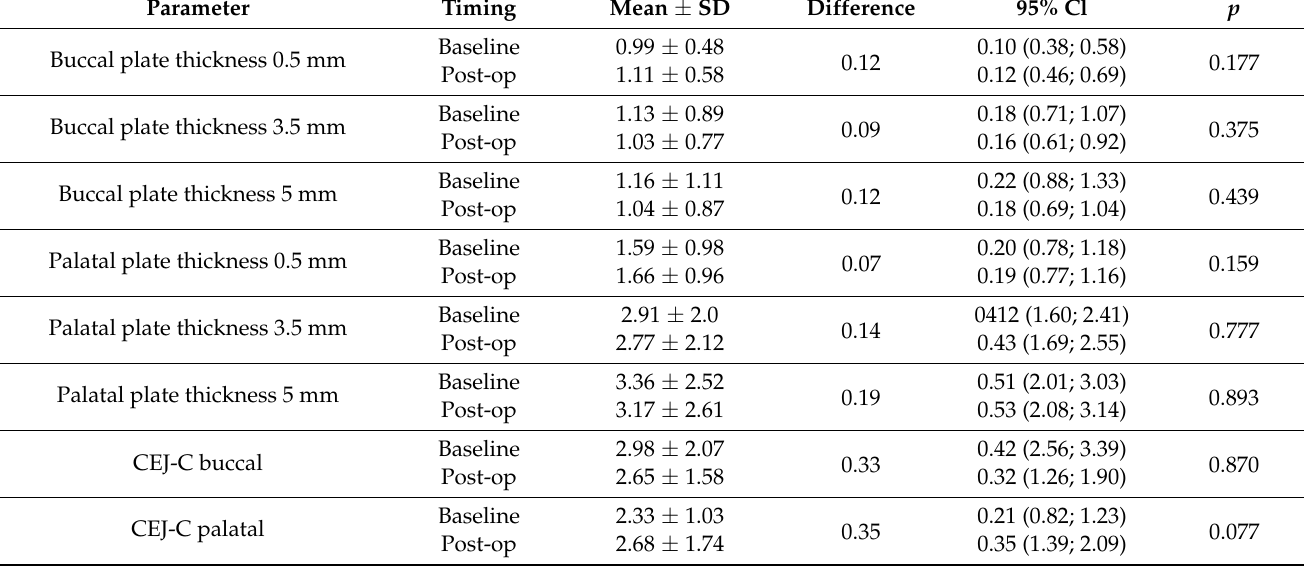
Table 6. Distribution of CBCT parameters for molars before and after orthodontic